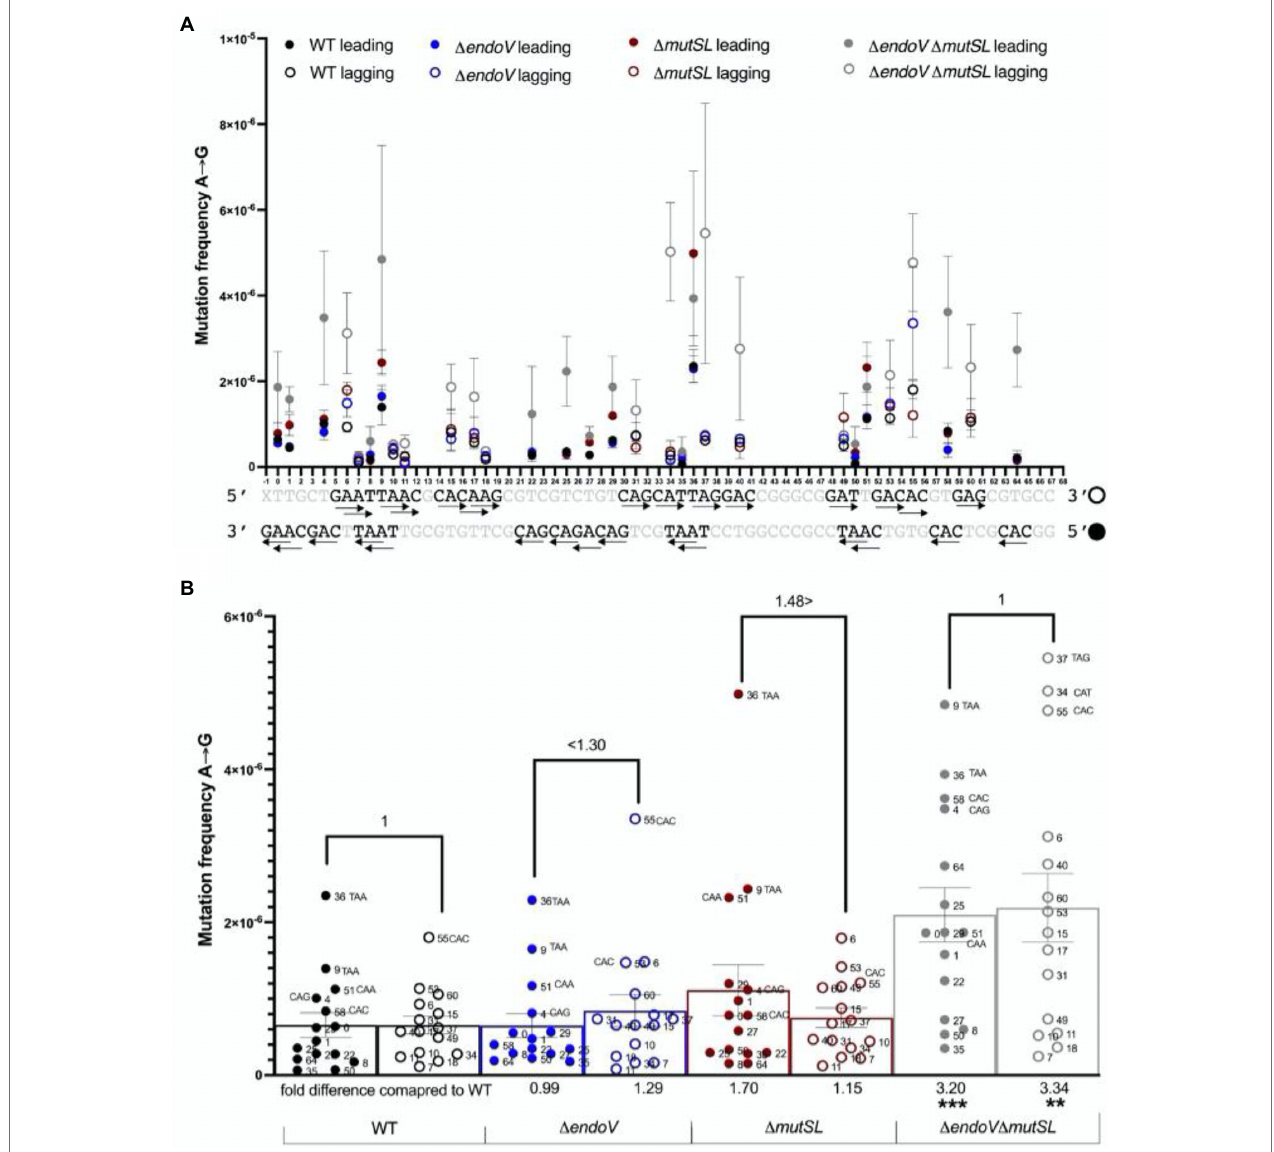
FIGURE 4 | Maximum Depth Sequencing of A → G substitutions in the leading and lagging strands of the B. subtilis strains indicated. (A) A → G Mutation frequency of every A position in each strand of the 68-bp ROI. The arrow → follows 5 ′ → 3 ′ polarity. Closed circles represent the leading strand, while open circles represent the lagging strand. (B) The bars represent the average frequency across the ROI considering the frequency of every A position (dots). Each dot represents the average frequency of two biological replicates. Error bars are SEM. Values, and symbols >; <, above connecting lines indicate fold differences of mutation frequencies between the leading and lagging strands of each strain. Values in X axis, compare fold differences of mutation frequencies between the leading and lagging strands of the mutant strains with those from the WT. **, p < 0.0097; ***, p < 0.0002 (by the Mann–Whitney